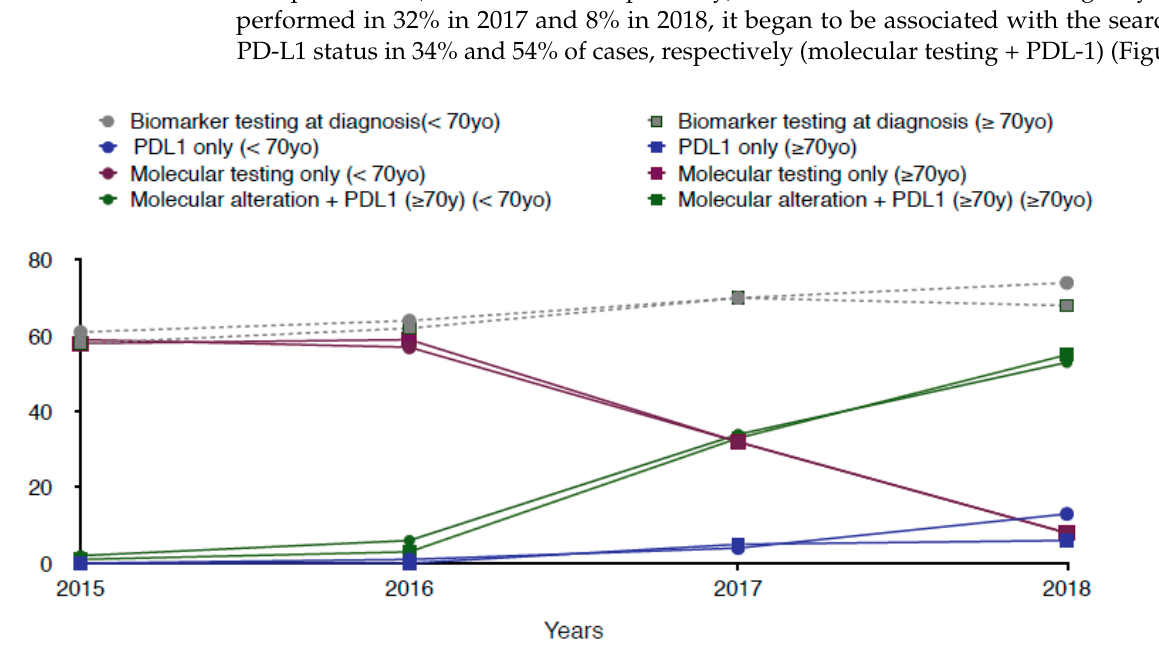
Figure 2. Molecular profiling over time according to age (<70 yo and ≥ 70 yo). Biomarker testing was defined as at least one molecular alteration and/or PD-L1 testing performed within 1 month before or 3 months after the non-squamous aNSCLC diagnosis. « Molecular testing only » meant testing for at least one molecular alteration excluding the search for PD-L1 status. Among molecular alteration testing listed in the database, we analyzed EGFR mutation, ALK translocation, KRAS mutation, BRAFV600E mutation, ROS1 translocation and/or rearrangement, HER2 mutation, and MET mutation and/or